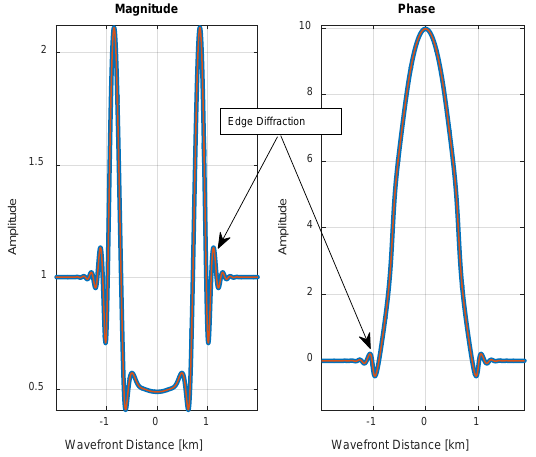
Figure 6. Phase Screen FDM and SM Error comparison 3.2 Time Delay The time delay occurs as a result of the phase delay in the E- field's propagation. Figure 7 shows the Global time delay in terms of chips. The color-bar represents the amplitude of the electric field as seen on the map. The wave front of the E-field spans the vertical axis. The secondary (delayed) wavefront that protrudes outward from the center of the initial received wavefront is caused by the edge diffraction from the Gaussian lens as noted in Figure